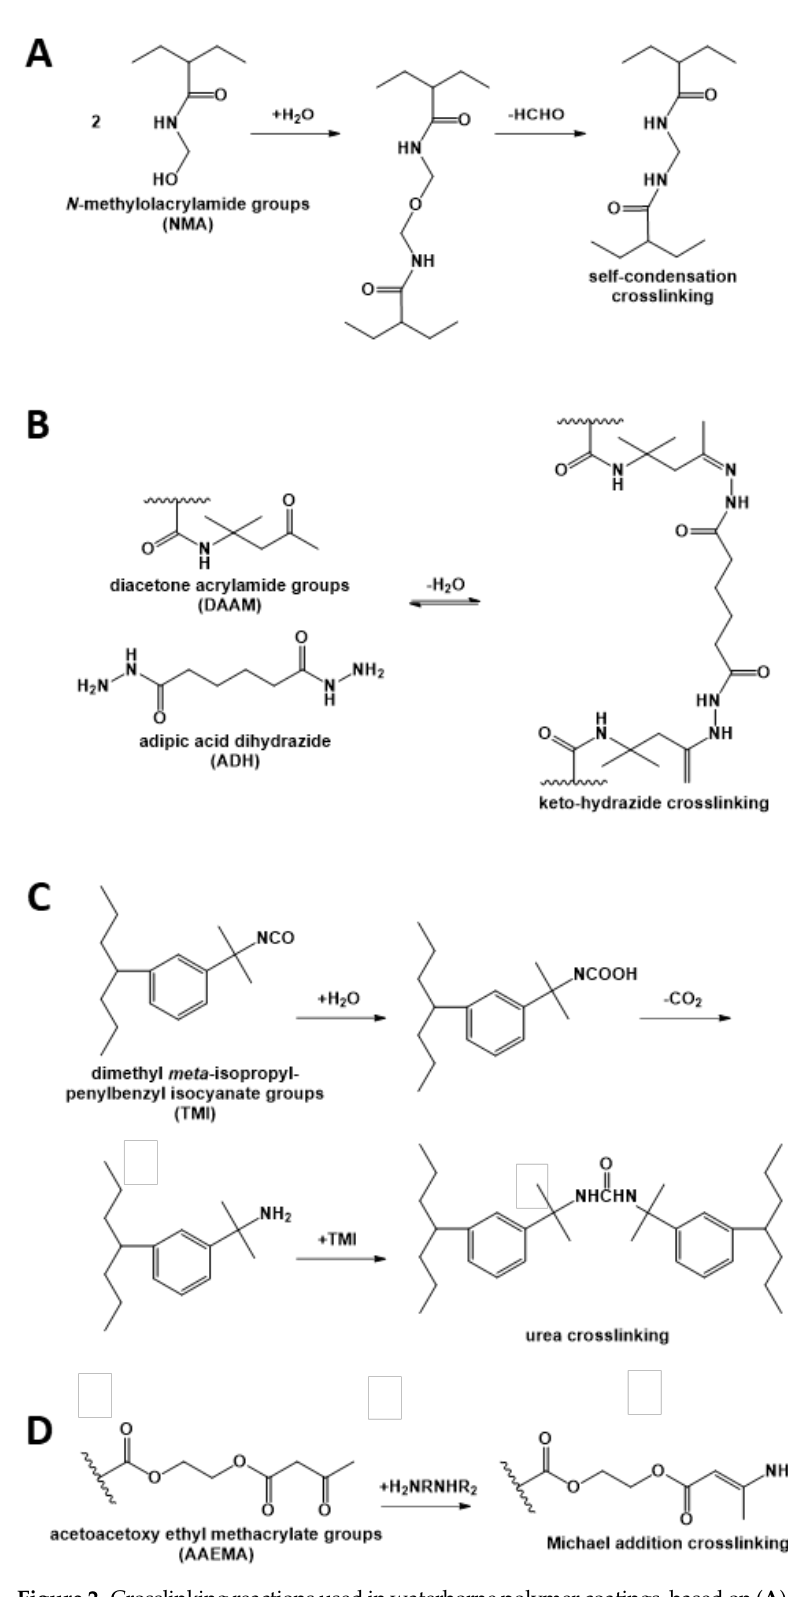
Figure 2. Crosslinking reactions used in waterborne polymer coatings, based on ( A ) N -methyloacrylamide; ( B ) diacetone acrylamide (DAAM) and adipic acid dihydrazide; ( C ) dimethyl meta-isopropenylbenzyl isocyanate (TMI); and ( D ) acetoacetoxy ethyl methacrylate (AAEMA) with a diamine.